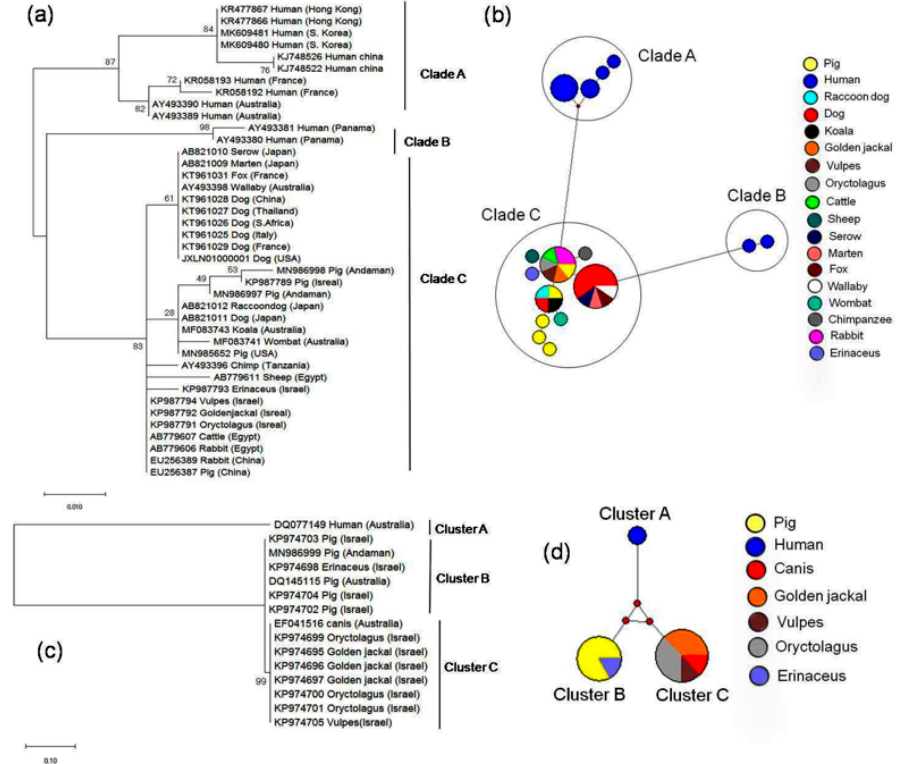
Figure 2. Evolutionary relationship of di ff erent isolates of S. scabiei . ( a ) COX1 based phylogenetic tree, ( b ) COX1 based network profile, ( c ) VSSC based phylogenetic tree, ( d ) VSSC-based network